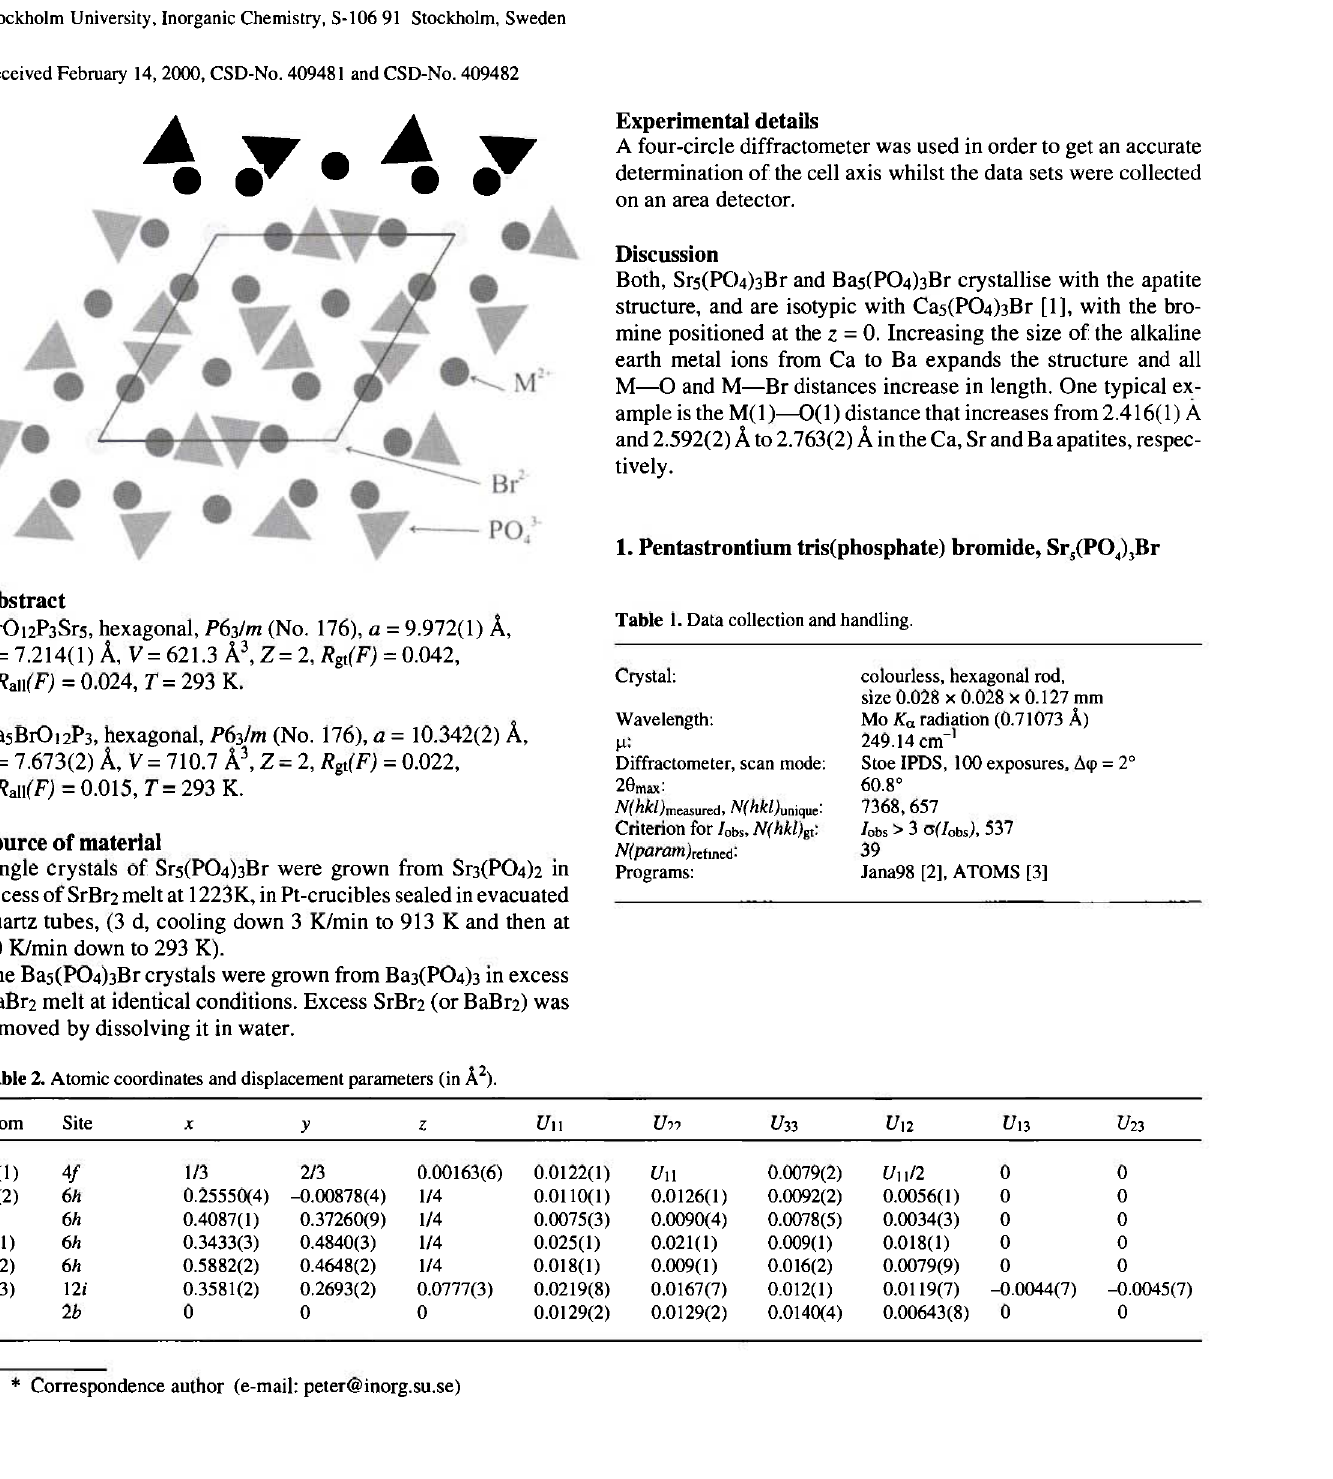
Table 1. Data collection and